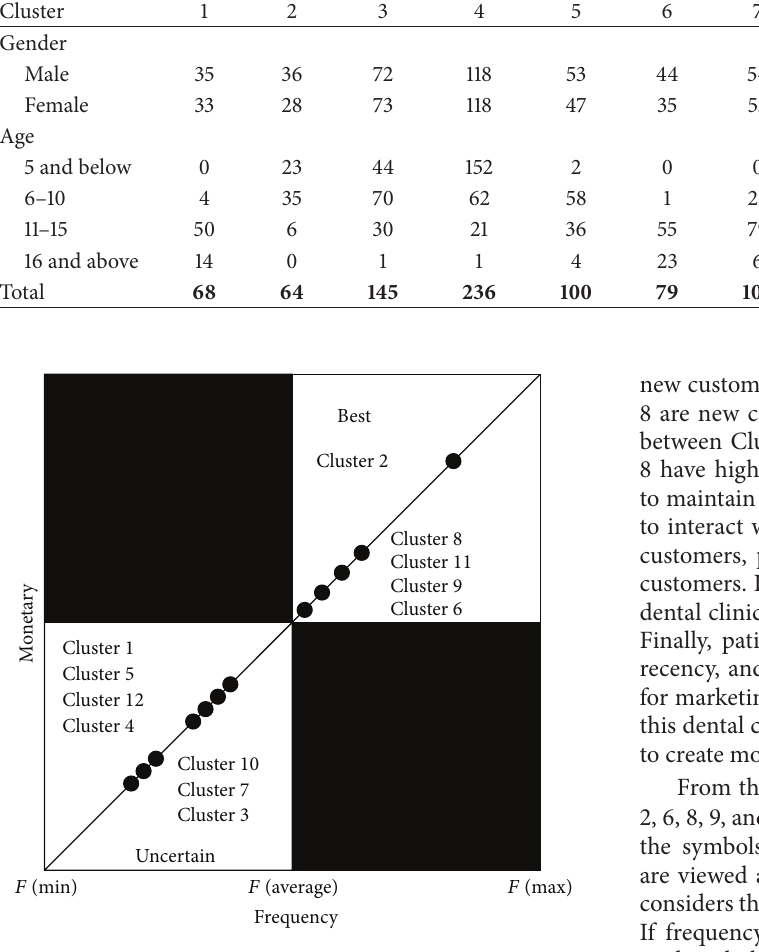
Figure 4: Twelve clusters depicted in customer value